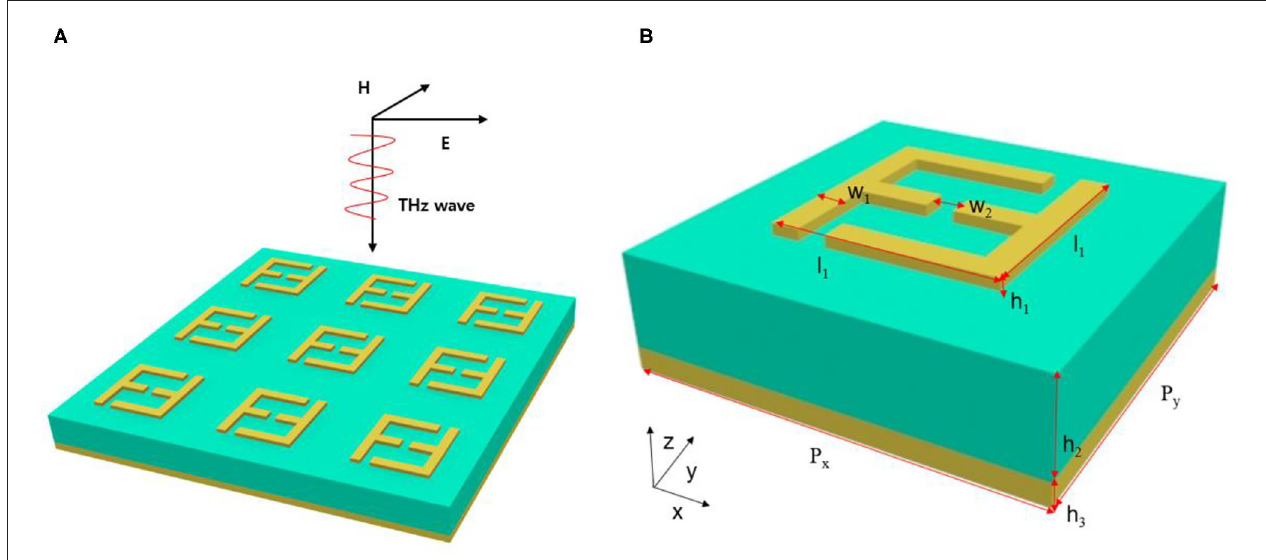
FIGURE 1 | Schematic of the metamaterial sensor (A) array of the sensor; (B) unit cell of the